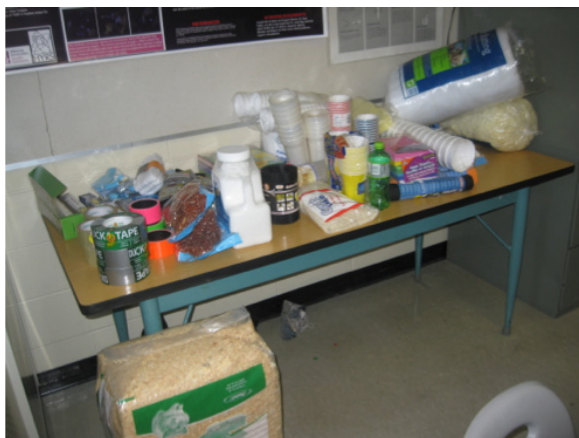
Figure 3. Example of Daily Blogs